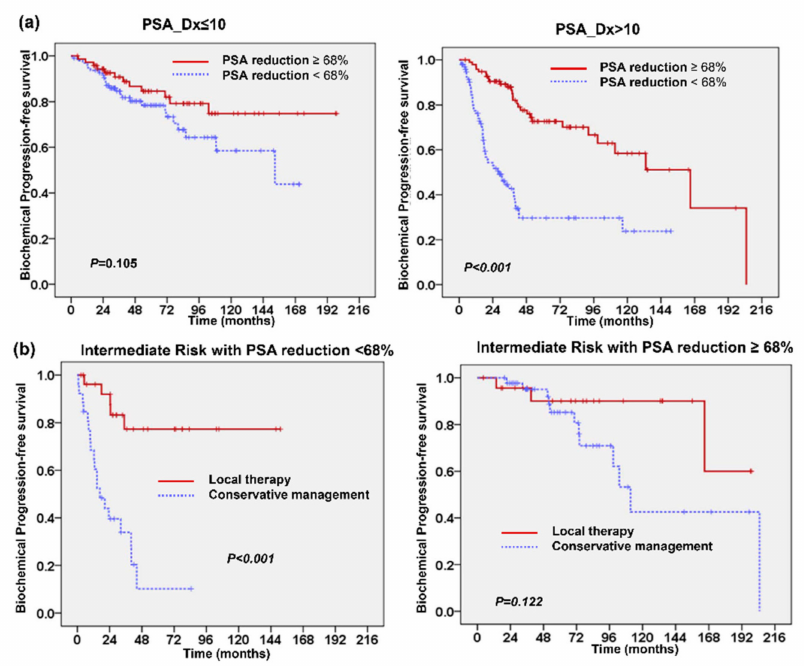
Figure 4. PSA reduction following TURP correlated with clinical outcome of patients with localized prostate cancer. Kaplan-Meier PFS survival curves showed that ≥ 68% PSA reduction following TURP was associated with better PFS in patients with higher PSA_Dx, but not for patients with lower PSA_Dx ( a ). Additionally, for patients in the intermediate-risk group, local therapy significantly improved the prognosis for patients with the PSA reduction <68%, but not for patients with greater PSA reduction ( b